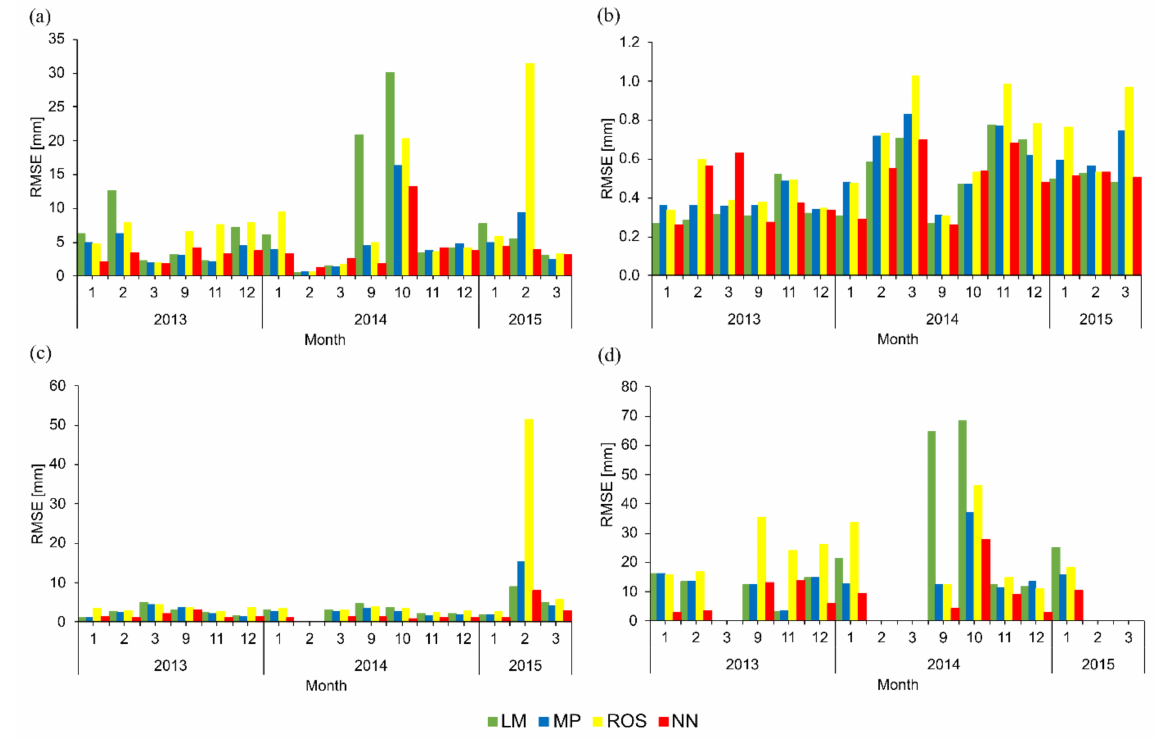
Figure 9. Plot of RMSE for monthly radar rainfall at ( a ) all, ( b ) low, ( c ) medium, and ( d ) high rain